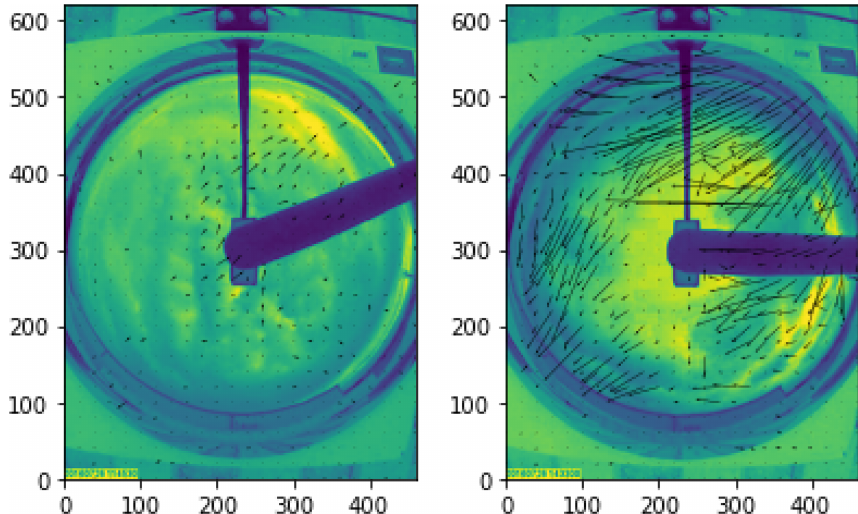
Figure 13. Two examples of the dense cloud motion field using the OF method, thinned by the factor of 20, show clustering of vectors in the image space. The mean cloud motion in Fig. 12a is underestimated due to the near-zero